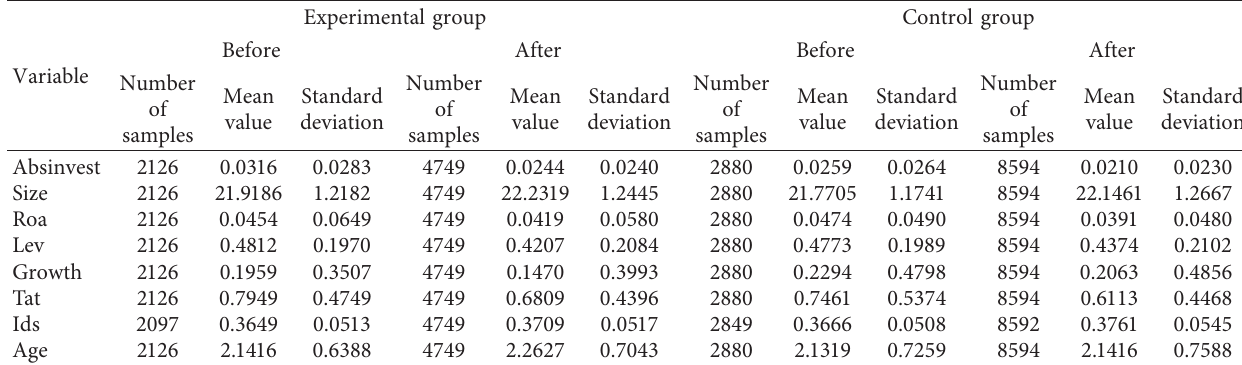
Table 3: Descriptive statistical analysis of the main variables before and after the policy.